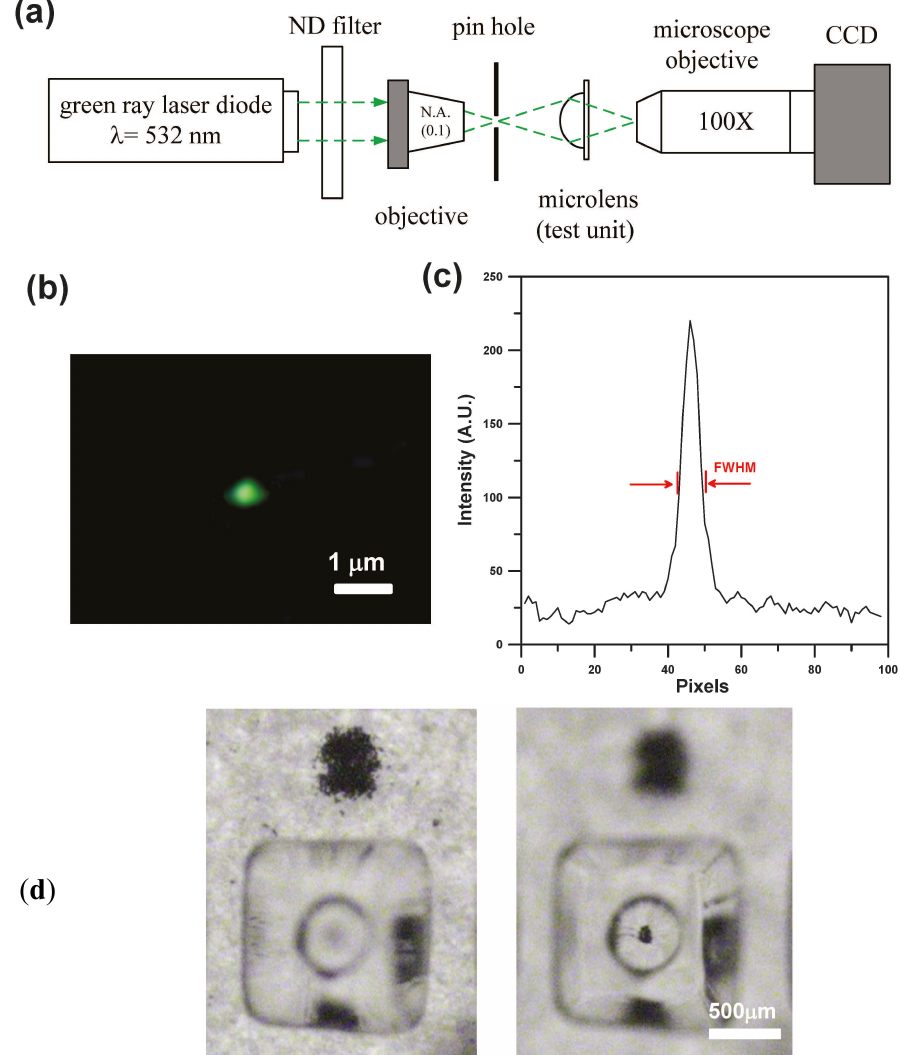
Figure 6. ( a ) Schematic illustrating an optical system set up to carry out spot size measurements. ( b ) The image and ( c ) the intensity distribution of the focus spot for the testing microlens structure produced by using 4× objectives and the EFM-3D mask filled with dye oil at C dye oil = 0.03 ( w / v ). ( d ) The images of a black ink dots observed by directly focusing the CCD on the paper ( left ) or through the produced microlens structure ( right